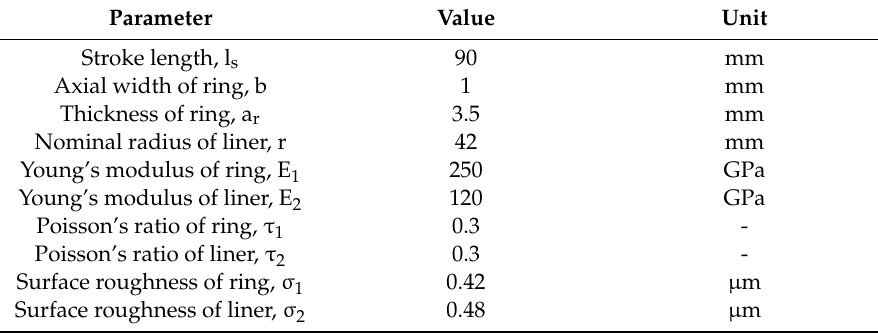
Figure 1. Schematic diagrams of the groove textured ring and ring-liner conjunction (RLC): ( a ) Groove textured ring; ( b ) groove textured RLC. Table 1. Geometry parameters of the RLC.